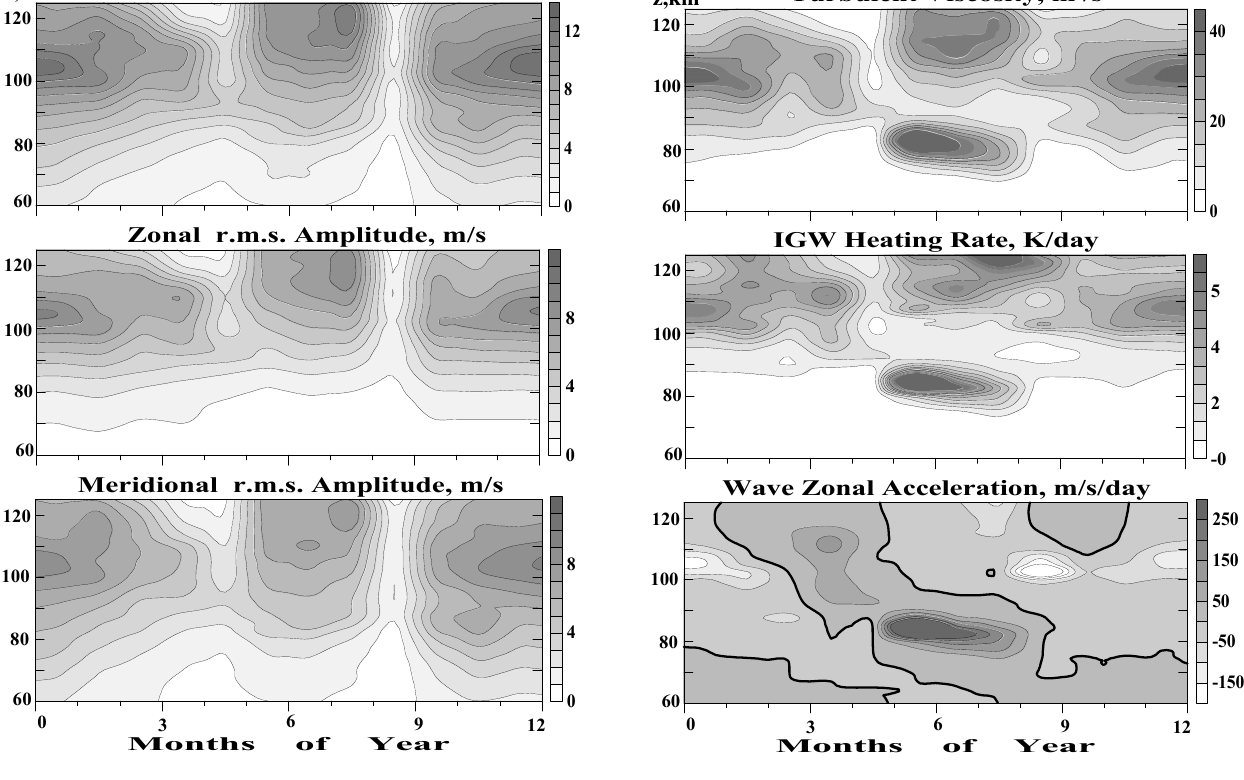
Fig. 6. “Gavrilov and Jacobi, A study of seasonal…” Fig. 6. Same as Fig. 3, but for IGW sources located above altitude Fig. 7. Calculated seasonal-altitude variations of turbulent viscosity 20km. Fig. 7. “Gavrilov and Jacobi, A study of seasonal…” (top), heating rate (middle) and zonal wave acceleration of zonal flow (bottom) produced by the set of IGW